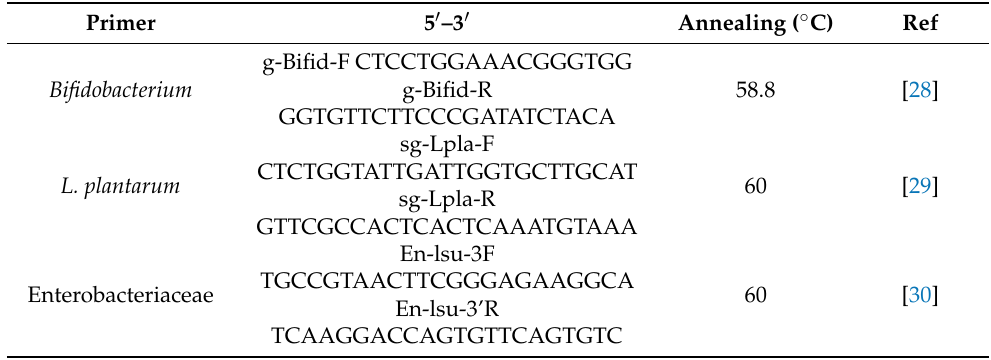
Table 1. The specific primers used in this